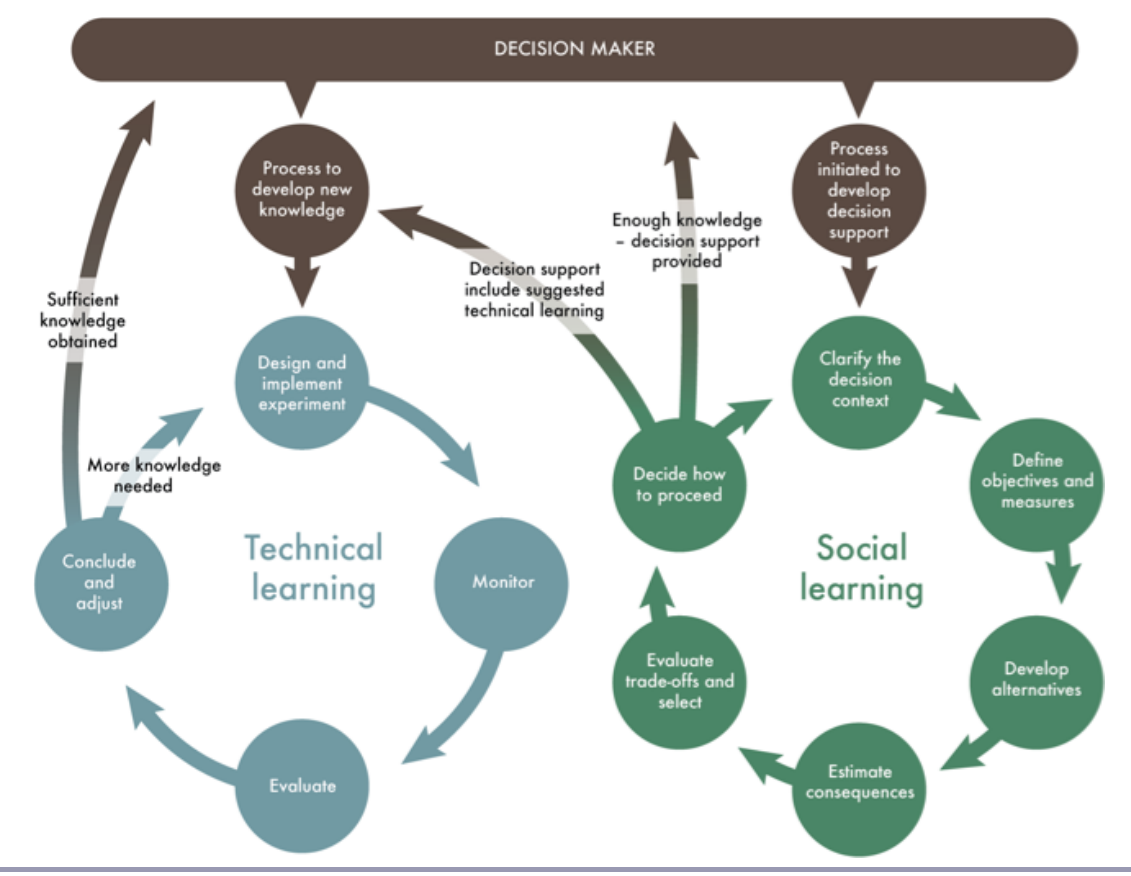
Fig. 1. Conceptual model of adaptive forest